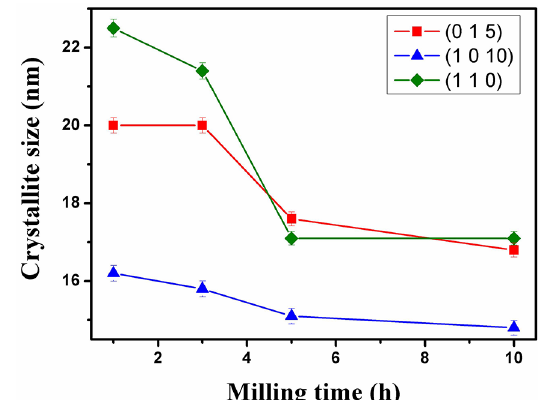
Te phase with increasing 2 3